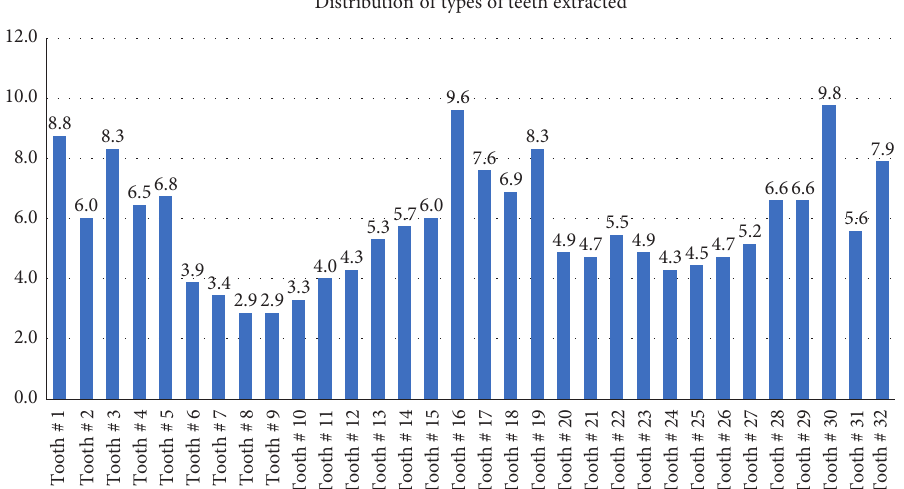
Figure 2: Distribution of type of teeth extracted among patients.